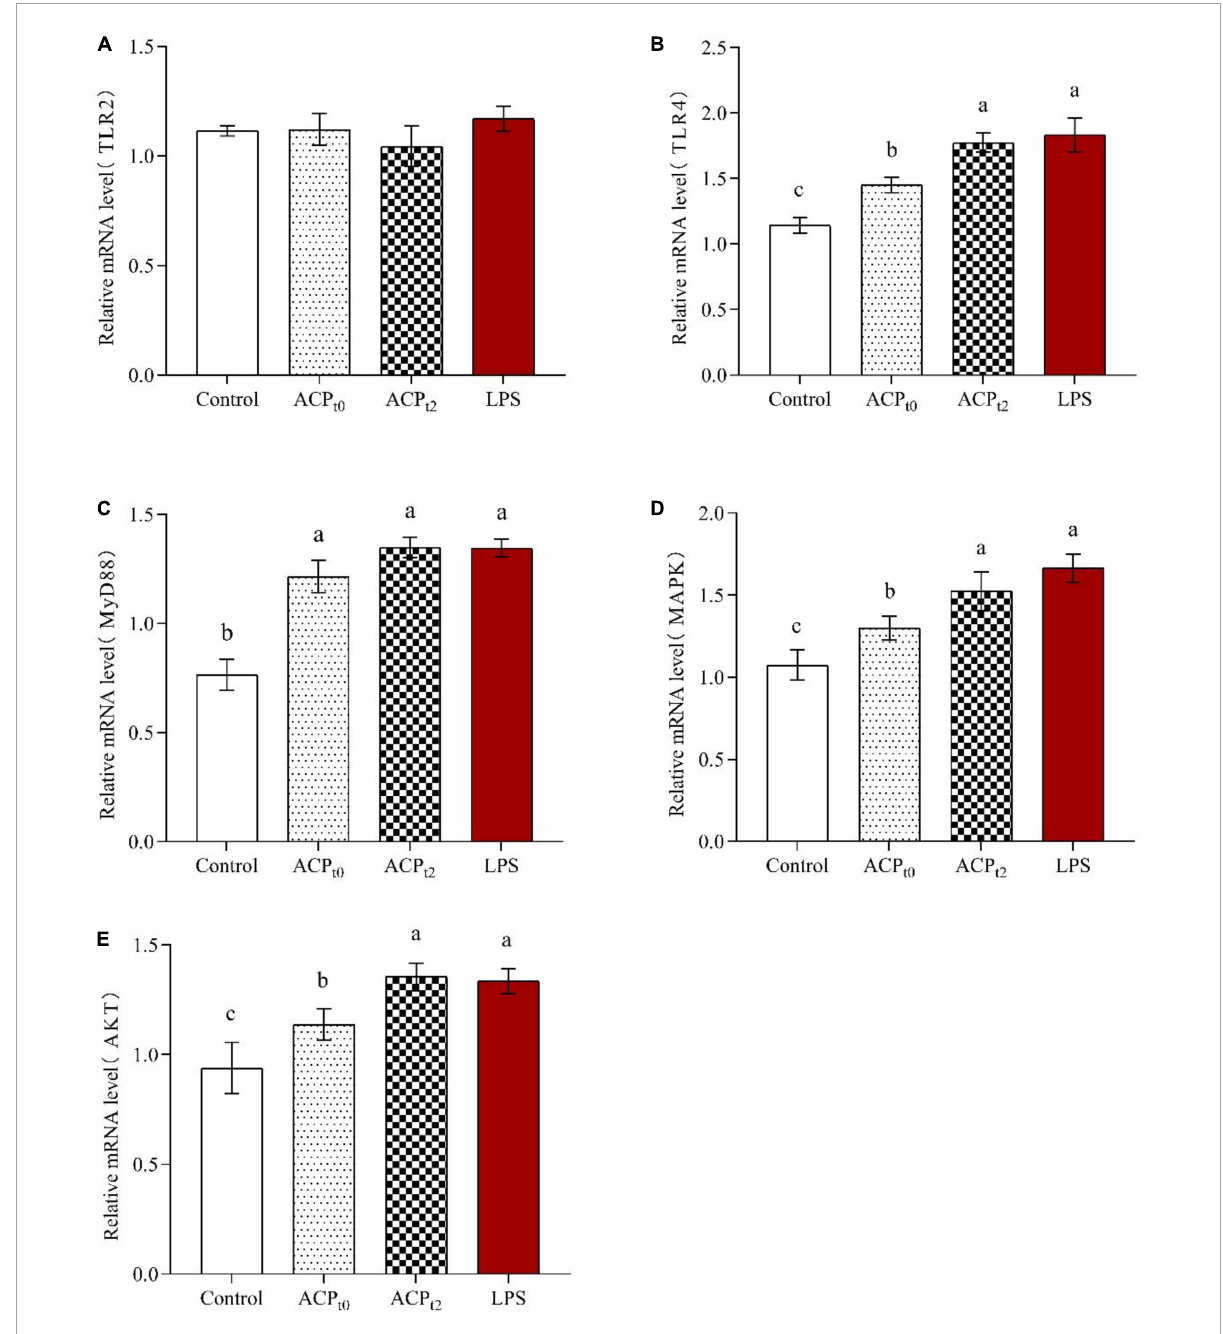
FIGURE8 Effects of ACP t 0 and ACP t 2 on relative mRNA expression levels of TLR2 (A) , TLR4 (B) , MyD88 (C) , MAPK (D) , and AKT (E) in macrophages. The different letters in the column indicate statistically significant differences ( P < 0.05).